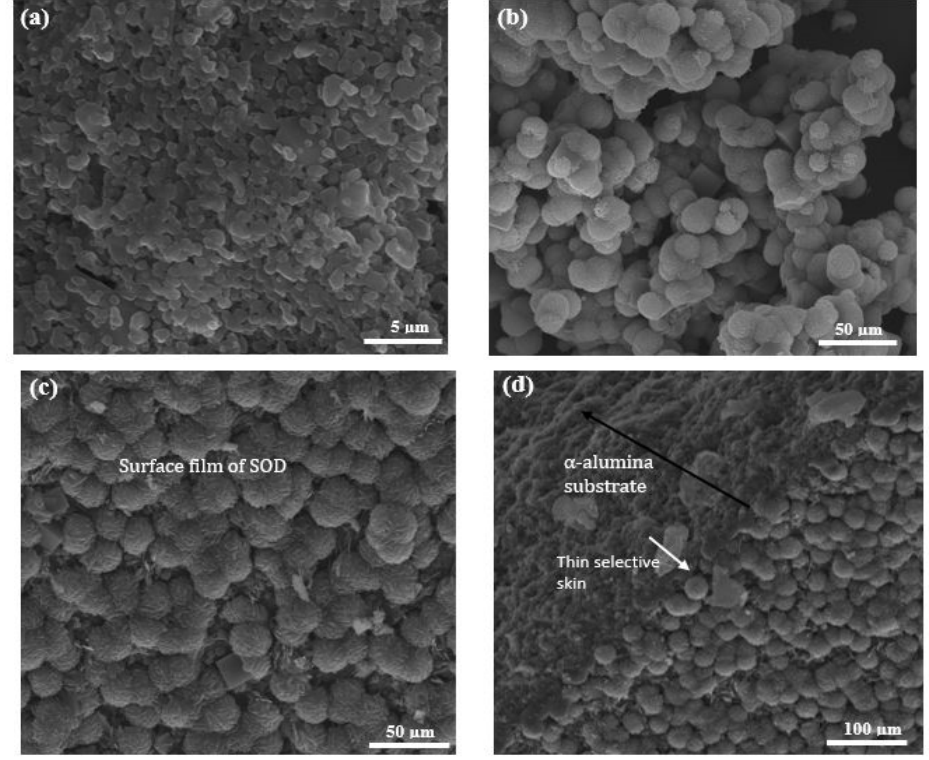
Figure 6. SEM images of ( a ) 200 nm layer (Innermost layer) of the α -Al 2 O 3 support; ( b ) SOD crystals obtained from the bottom of the autoclave during PPH, ( c ) surface of membrane prepared via the direct hydrothermal synthesis, and ( d ) cross-section of membrane prepared via the direct hydrothermal synthesis.